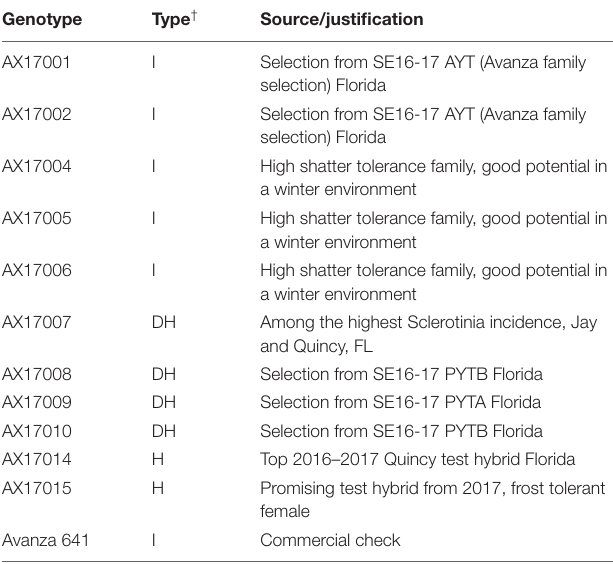
TABLE 1 | Details of Brassica carinata genotypes used in the